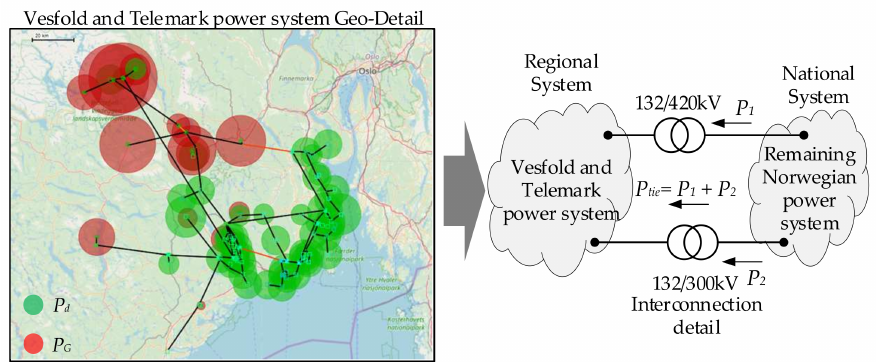
Figure 9. Geographical representation of the Vestfold and Telemark power system.